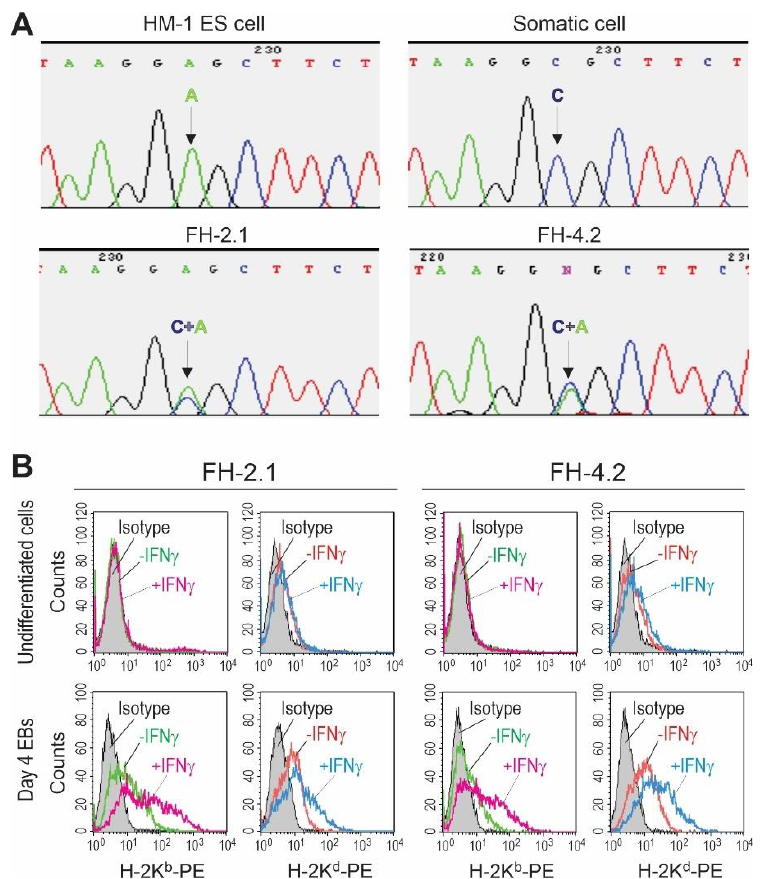
Figure 2. Identification of both parental genomes in fusion-hybrid-derived PSCs. ( A ) Representative example of identification of both parental genomes in FH-PSCs using single nucleotide polymorphism (SNP) genotyping. The DNA locus encompassing the selected SNP on chromosome 7 was amplified by PCR and sequenced. Only one polymorphic allele could be detected in HM-1 ESCs (adenine, A) and somatic cells (cytosine, C). In contrast, FH-PSC lines contained both variant alleles (C/A) at this SNP position, suggesting the existence of both parental genomes in these cells. Complimentary analyses were performed for all autosomes and are summarized in Table S2. ( B ) Expression of major histocompatibility (MHC) class I molecules on the surface of fusion-derived PSCs FH-2.1 and FH-4.2. The levels of MHC class I molecules of parental ESCs (H-2K b ) and somatic cells (H-2K d ) were determined on intact (−IFNγ) or interferon-gamma-treated (+IFNγ) (100 ng/mL, 2 days) FH-PSCs at undifferentiated (upper panels) and differentiating state (day 4 EBs, lower panels) by flow cytometry.